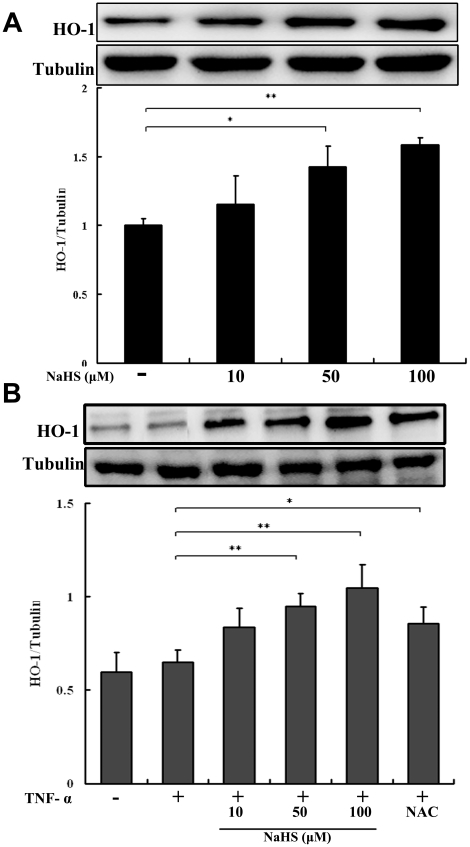
NaHS upregulated expression of HO-1 in HUVEC.(A) HUVEC were incubated with indicated concentrations of NaHS for 6 hours. Cells were then lysed, and HO-1 expression was analyzed by Western blot. Tubulin was used as loading control. Data represent mean ±S.E.M from 3 independent repeats. *P<0.05, **P<0.01 compared with unstimulated cells. (B) HUVEC were incubated with various concentrations of NaHS for 30 min, cells were then stimulated with TNF-α (10 ng/ml) for 6 h. HO-1 proteins were analyzed by Western blot in HUVEC. Tubulin was used as loading control. NAC concentration was 5 mM. #
P<0.05 compared with unstimulated cells, *
P<0.05, **
P<0.01 compared with TNF-α-stimulated cells. Data are the mean ±S.E.M of results from at least three independent experiments, each performed in duplicate.